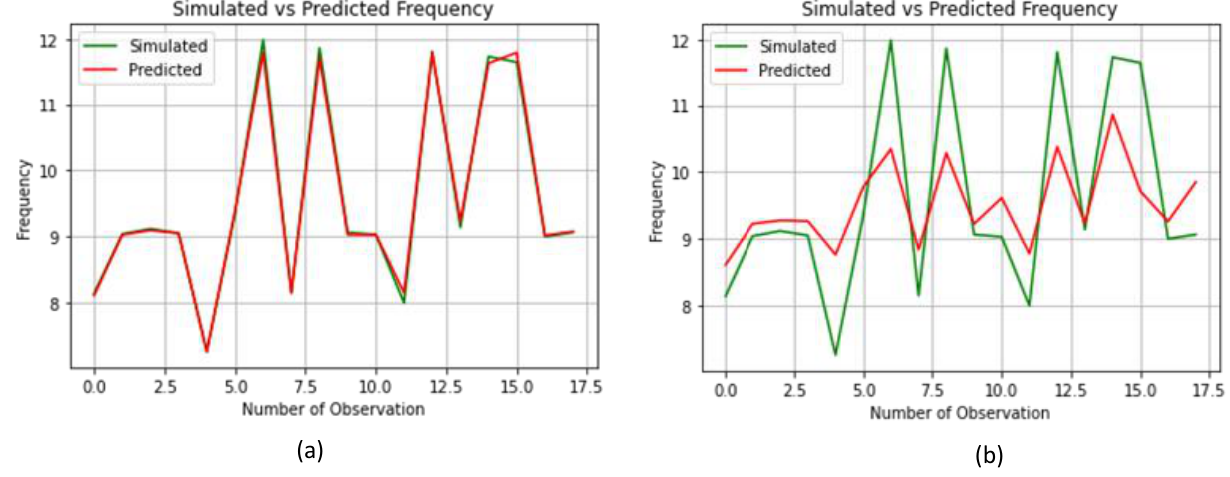
Figure 14. Simulated vs. predicted frequency using ( a ) DTR and ( b ) CNN.